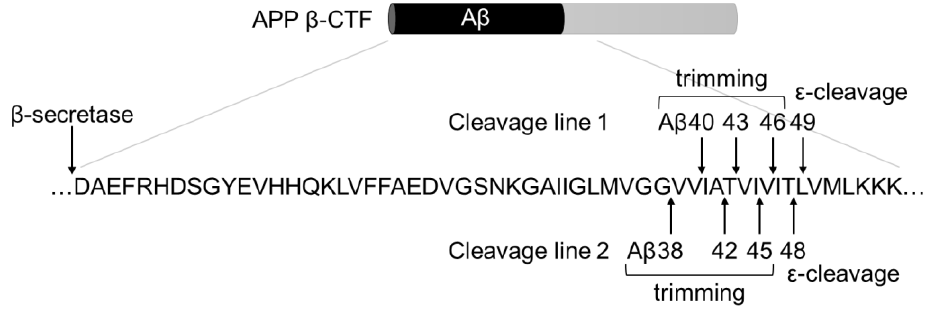
Figure 1. Cleavage model of APP β-CTF by γ-secretase. APP is cleaved by β-secretase to form β- CTF, and β-CTF is cleaved by γ-secretase. γ-Secretase is cleaved sequentially through ε-cleavage, followed by trimming. Two types of cleavage lines exist: one produces Aβ49 through ε-cleavage, followed by Aβ46 → 43 → 40 trimming (cleavage line 1), and the other produces Aβ48 through ε- cleavage, followed by Aβ45 → 42 → 38 trimming (cleavage line 2).